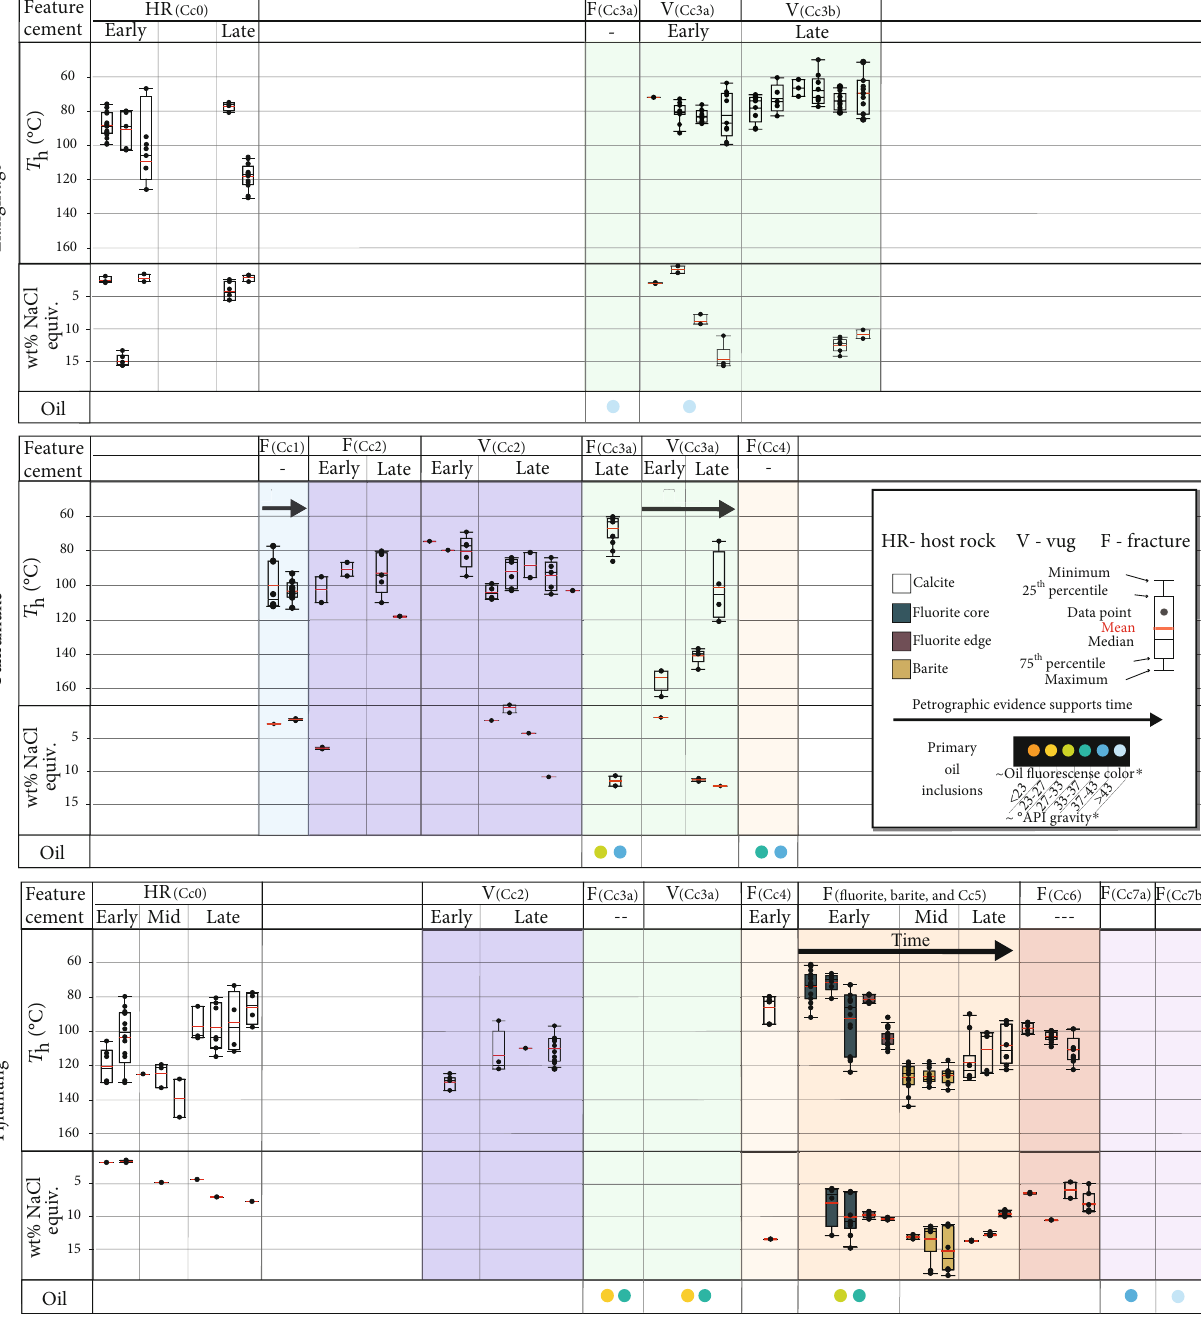
Figure 11: Box and whisker plots showing microthermometry results of two-phase aqueous inclusions (minimum trapping and salinity) for individual FIAs arranged by formation and diagenetic feature in chronological